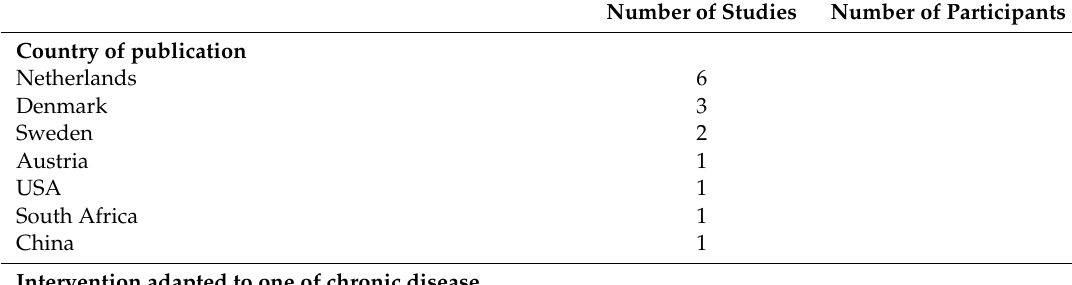
Table 2. Summary of the characteristics of the included